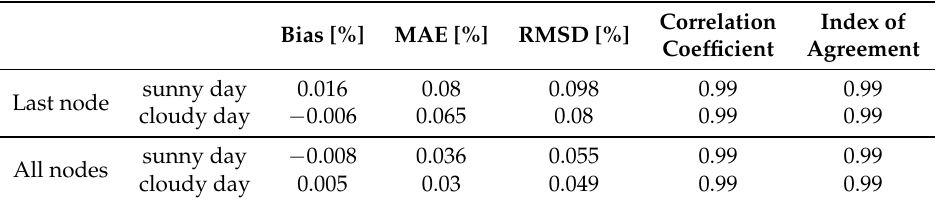
Figure 12. The estimated and actual values of the last node voltage (cloudy day). Table 1. Performance indexes for